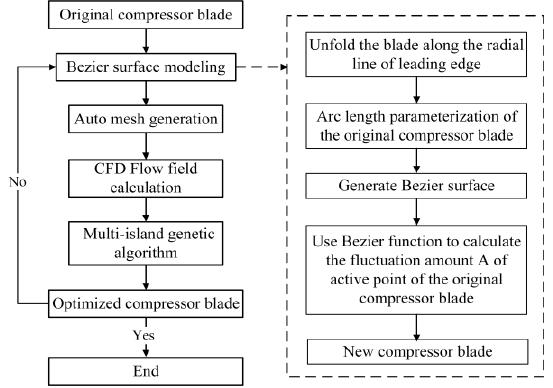
Figure 8. Optimization process of the highly loaded compressor.